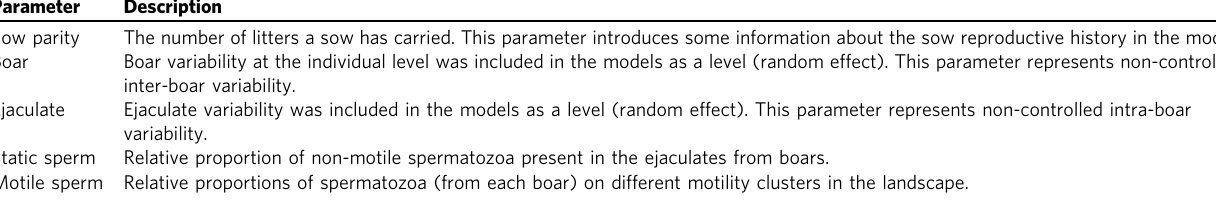
Table 3 Parameters used for inference of boar fertility.